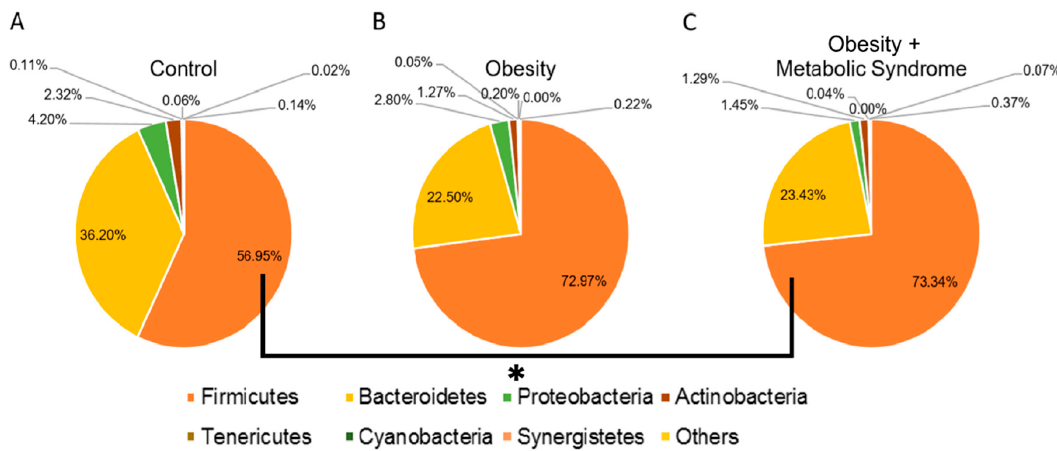
Figure 1. Bacterial phyla abundance. The figure shows circle charts of the relative abundance of relevant bacterial phyla in the three phenotypic categories. ( A ) Control; ( B ) obesity, and ( C ) obesity + metabolic syndrome. Phyla are identified by colors as indicated underneath the charts. Others includes phyla such as Verrucomicrobia, Spirochaetes, and Fusobacteria. Numbers are the relative abundance in percentage. Solid line and asterisk indicate a significant difference in the relative abundances for the phylum Firmicutes between the control and obesity + metabolic syndrome.